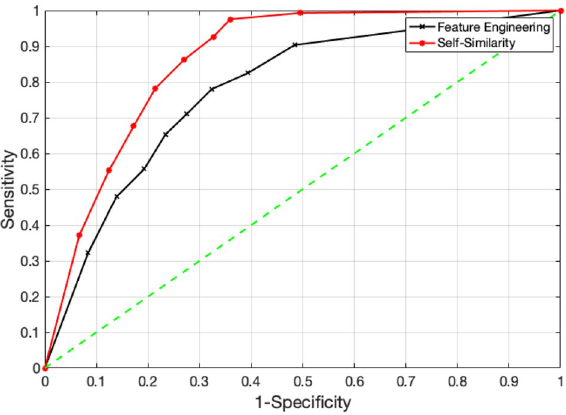
Figure 4. ROC curves obtained by using the feature engineering and self-similarity-based feature matrices.